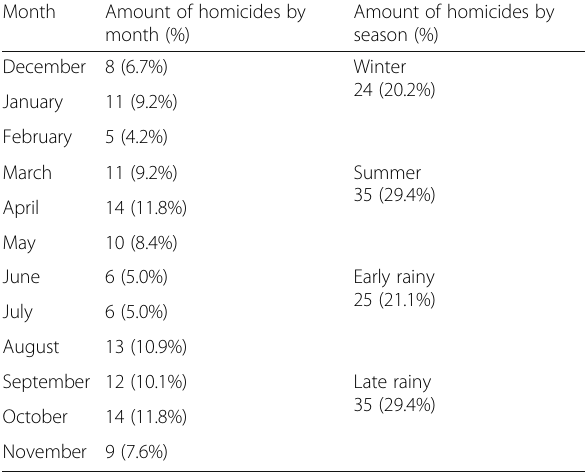
Table 2 Amount of homicides by month and